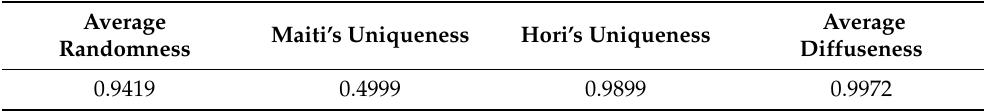
Table 2. Measurements on 100 PUF instances CRP sets.